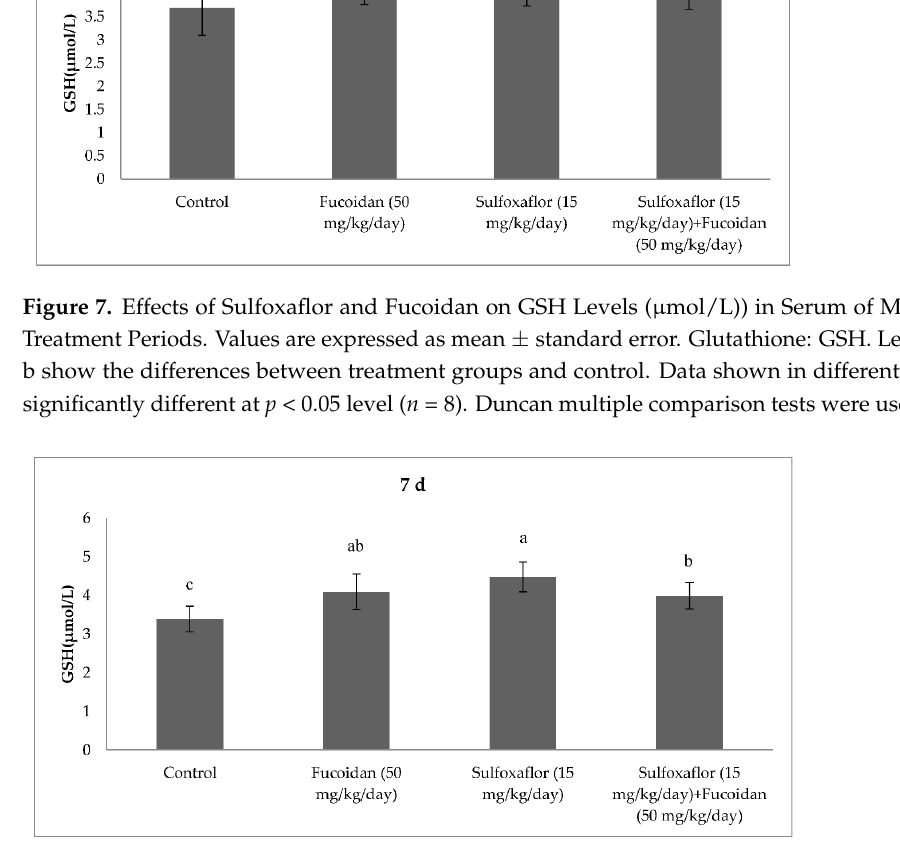
Figure 8. Effects of Sulfoxaflor and Fucoidan on GSH Levels (µmol/L) in Serum of Mice at 7-d Treatment Periods. Values are expressed as mean ± standard error. Glutathione: GSH. Letters a, b and c show the differences between treatment groups and control. Data shown in different letters are significantly different at p < 0.05 level ( n = 8). Duncan multiple comparison tests were used.